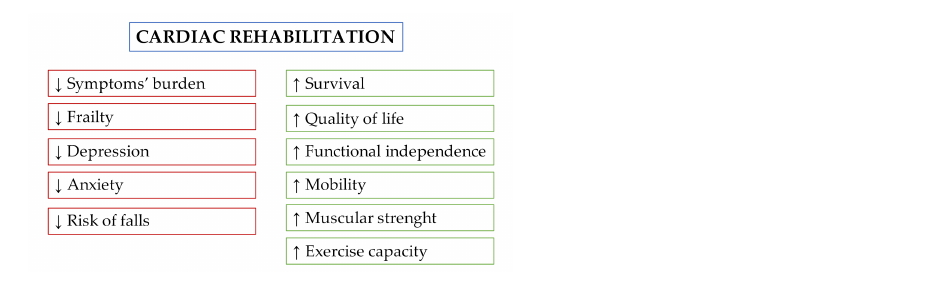
Figure 2. Effects of cardiac rehabilitation in patients undergoing transcatheter aortic valve